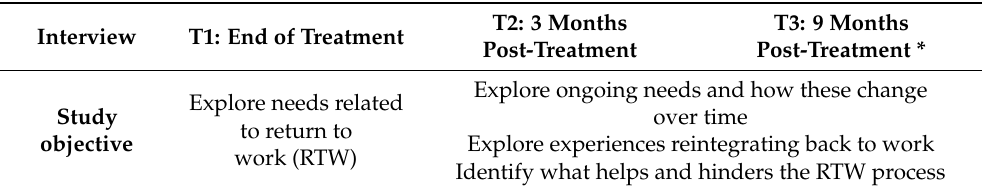
Table 2. Key findings as they relate to interview timepoints and study objectives. T1 = timeline 1; T2 = timepoint 2; T3 = timepoint